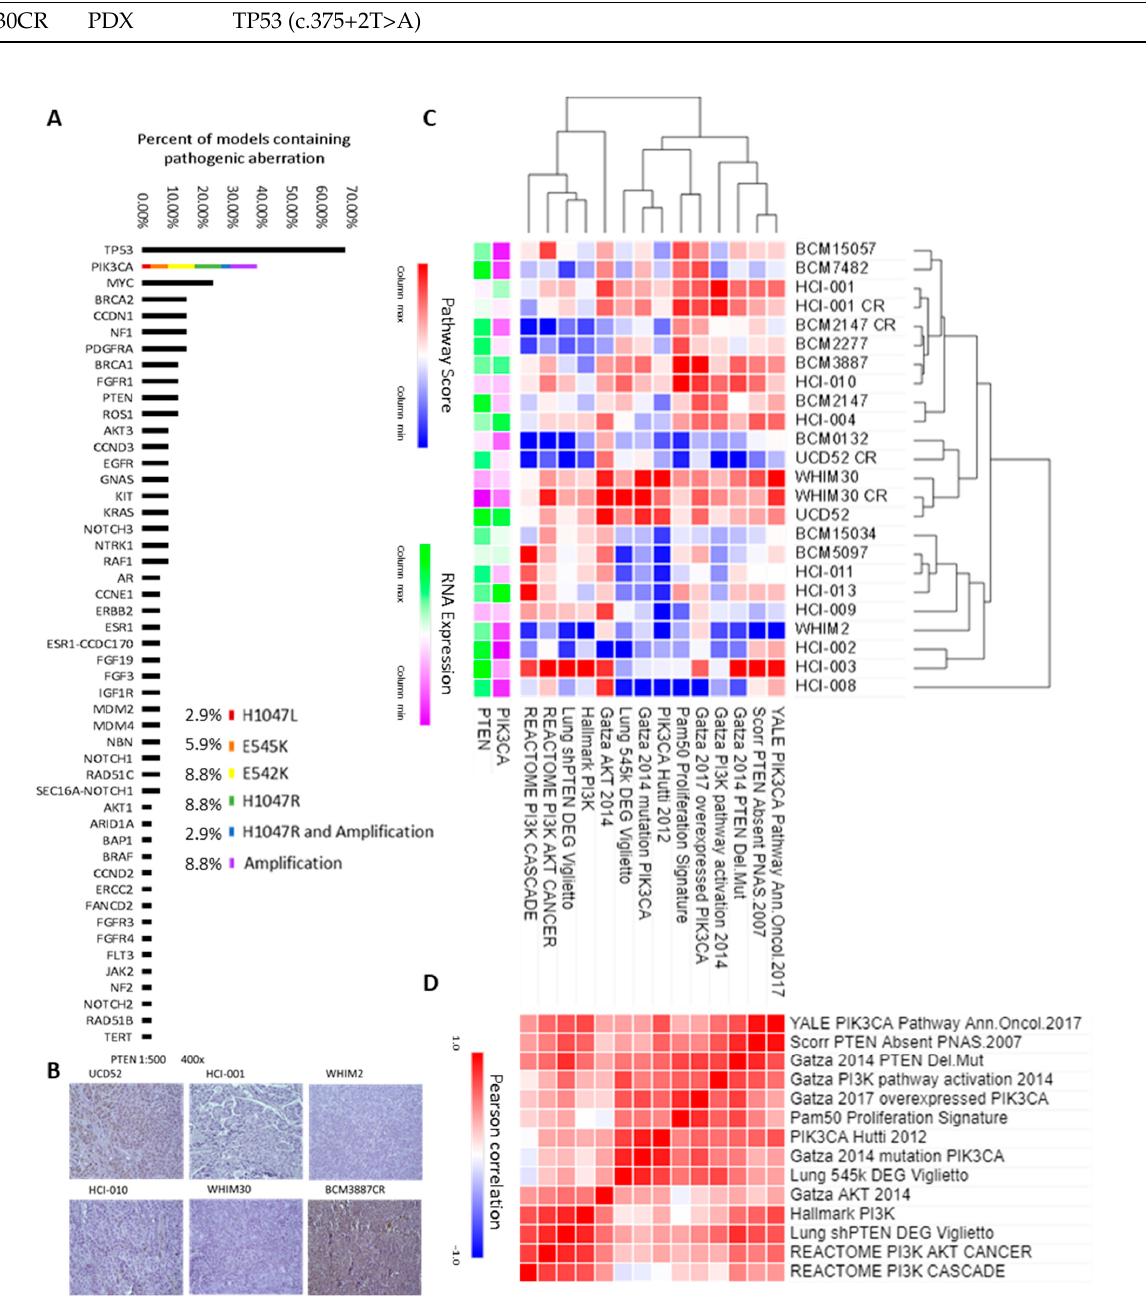
Figure 1. High PIK3CA gene aberration and pathway enrichment in many PIK3CA wt PDX models. ( A ) Percent oncogenic aberrations. ( B ) IHC for PTEN for 6 basal-like breast cancers. ( C ) Hierarchical clustering of PDX models by previously published PIK3CA-related gene signatures and ( D ) Similarity matrix of those signatures.